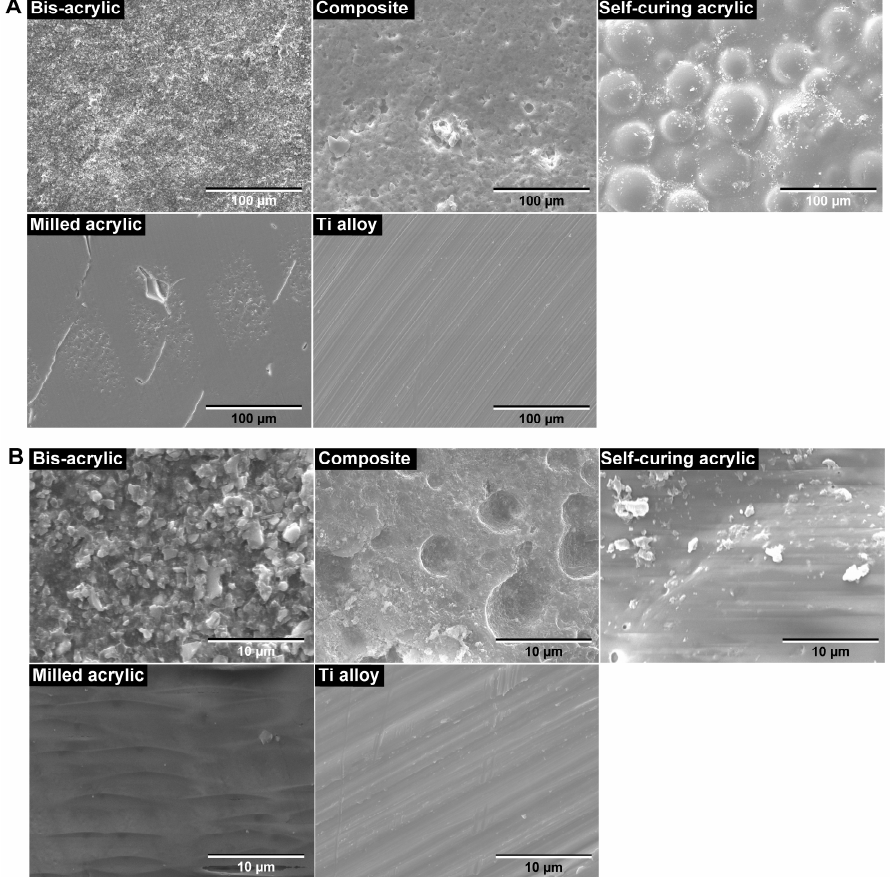
Figure 2. Surface topography of the test materials by scanning electron microscopy (SEM). ( A ) Low- magnification SEM images (×1000). ( B ) High-magnification SEM images (×10,000).